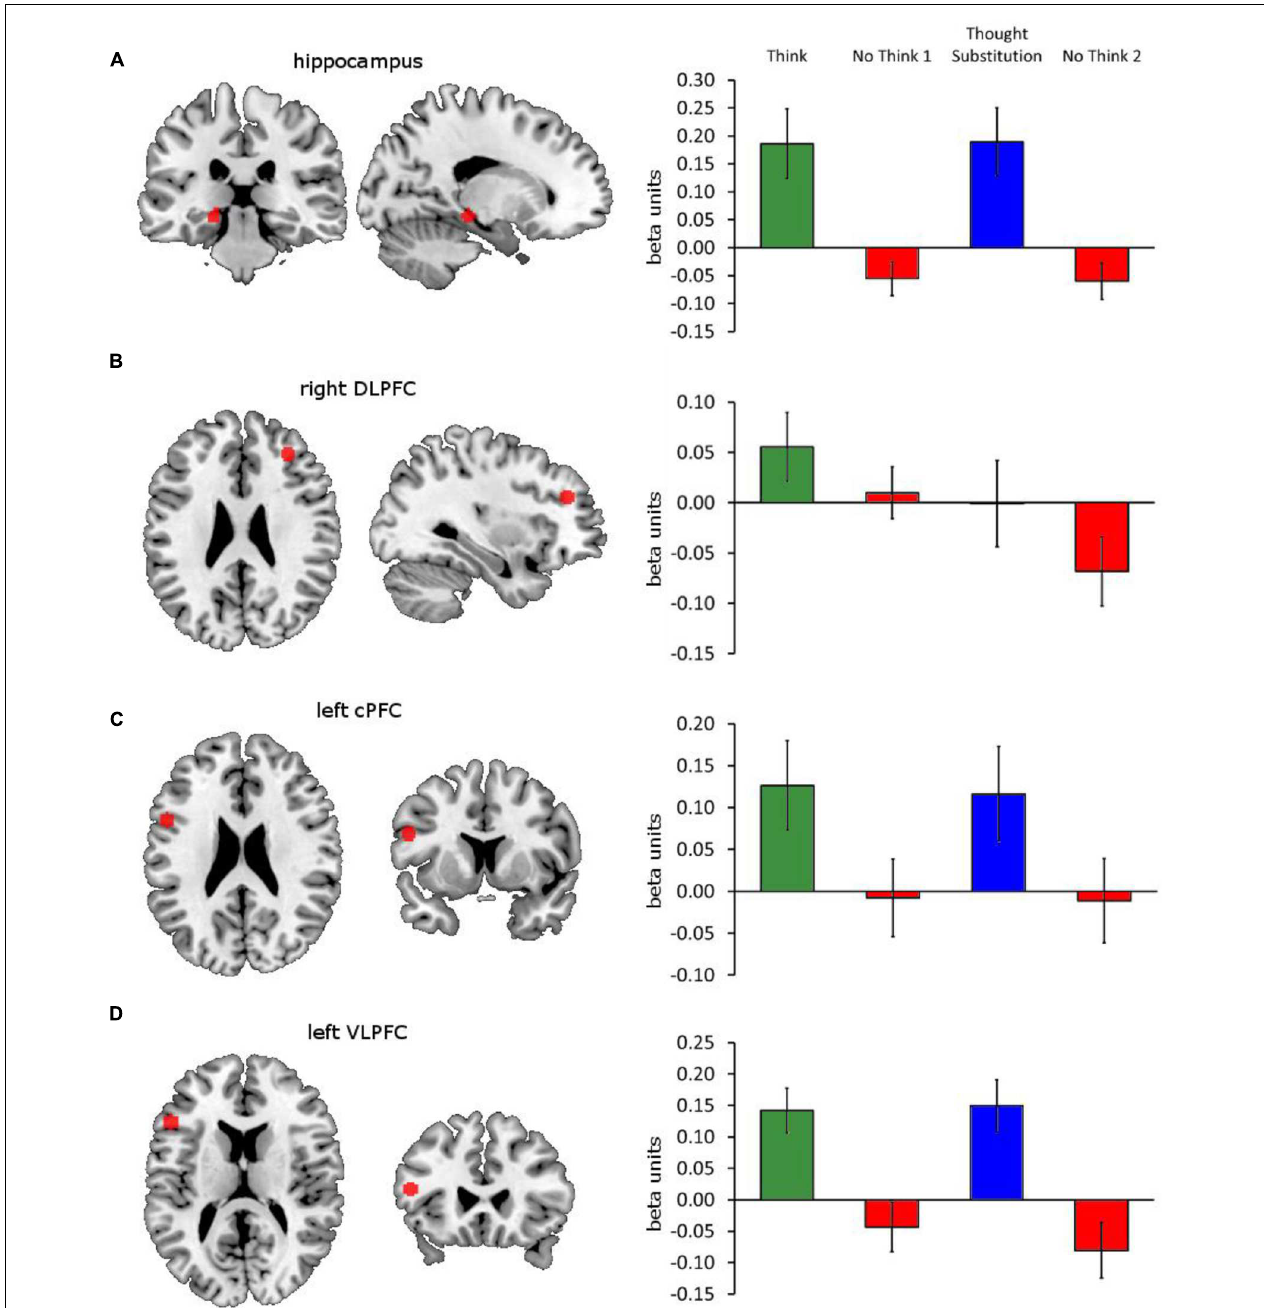
FIGURE 4 | Four ROIs and their beta amplitude responses. Illustrations of the ROIs in red (left) and their beta amplitude responses to think, memory substitution, no-think1 and no-think2 (right) are shown for (A) left hippocampus, derived from a cluster within the think vs. threshold contrast thresholded at p < 0.0001, and 5 mm radius spheres centered on (B) right DLPFC [32, 38, 26], (C) left caudal PFC (cPFC) [ − 52, 9, 24] and (D) left VLPFC [ − 50, 25, 14] (BA 45). Error bars represent + 1